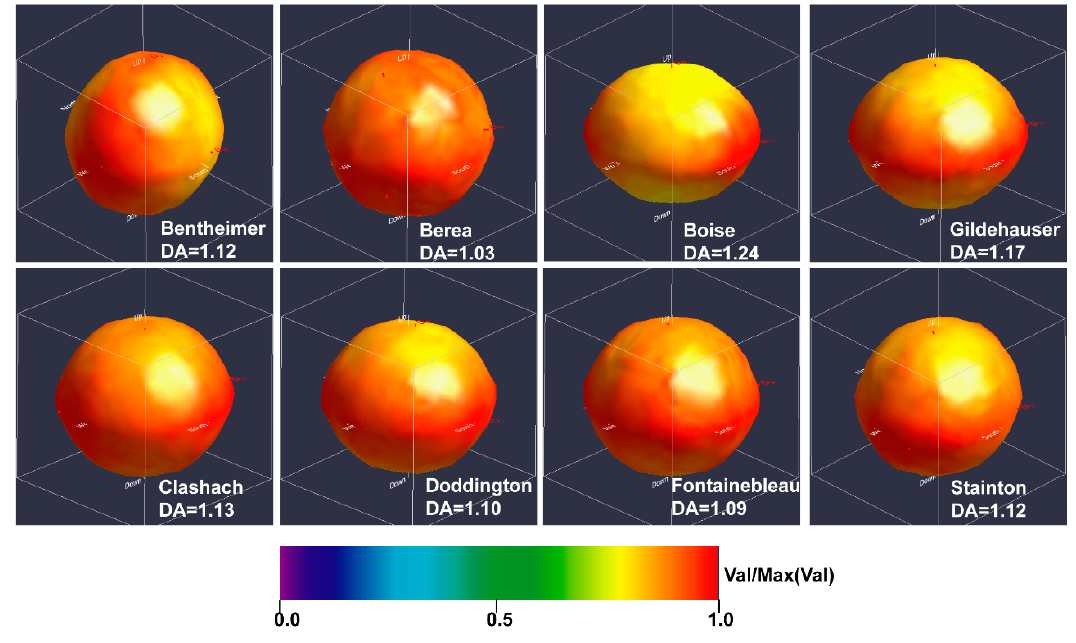
Figure 8. 3D rose plots for pores within sandstone samples. Table 2. Quantified topological